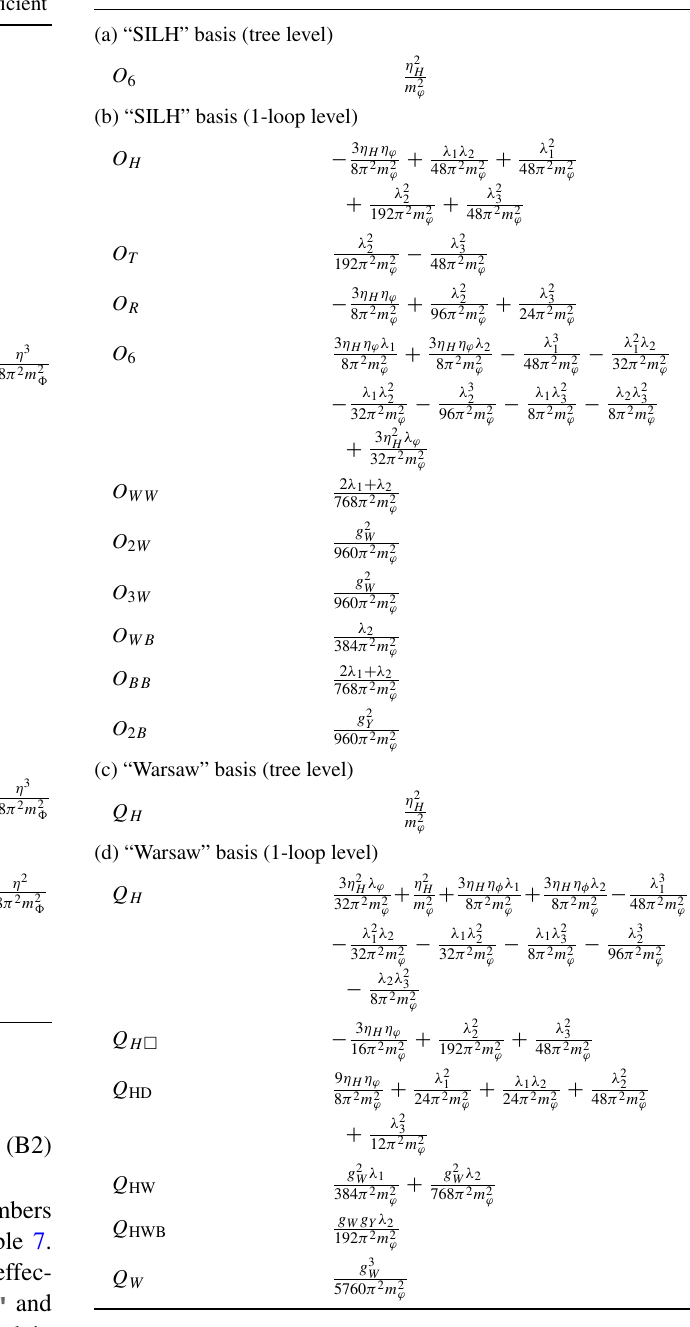
Table9 EffectiveoperatorsandWilsoncoefficientsfortwoHiggsdou- blet model (2HDM). The SILH basis result is available in Ref. [19]. The terms marked in ‘Red’ differ from the results derived in the mentioned reference. As light–heavy mixing (which can be ignored safely for phe- nomenological analyses) is not included, this result is